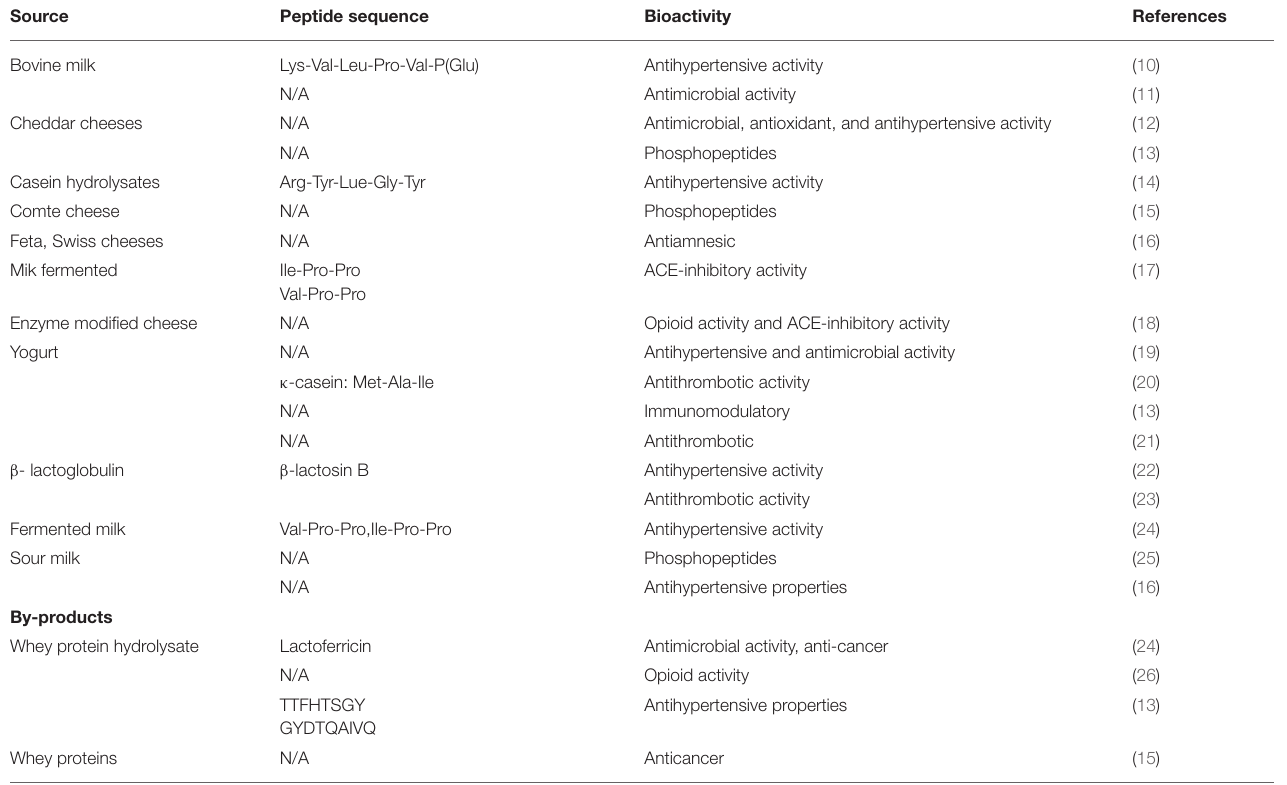
TABLE 1 | Peptides from milk and by-products and their